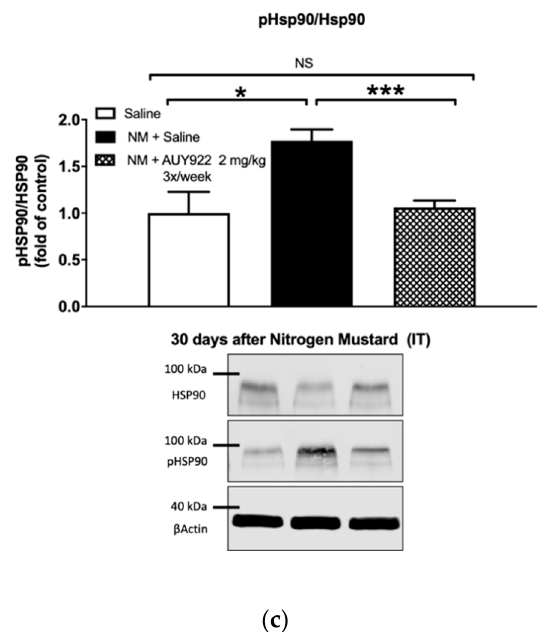
Figure 8. The HSP90 inhibitor, AUY-922, blocks the NM-induced increase in HSP90 activation (phosphorylation, p-HSP90) in mouse lung homogenates, analyzed by Western blotting. Mice received 0.625 mg/kg NM or saline (2 μ L/g body weight, intratracheally) on day 0. They then received AUY-922 (1 mg/kg, 2×/week or 2 mg/kg 3×/week intraperitoneally) for 10 ( a ) or 30 ( b , c ) days, starting 24 h after NM. Protein quantification is expressed as fold of control mice. Means ± SEM; n = 4 mice per group; *: p < 0.05, **: p < 0.01, ***: p < 0.001, NS: not significant with ANOVA and Turkey’s.